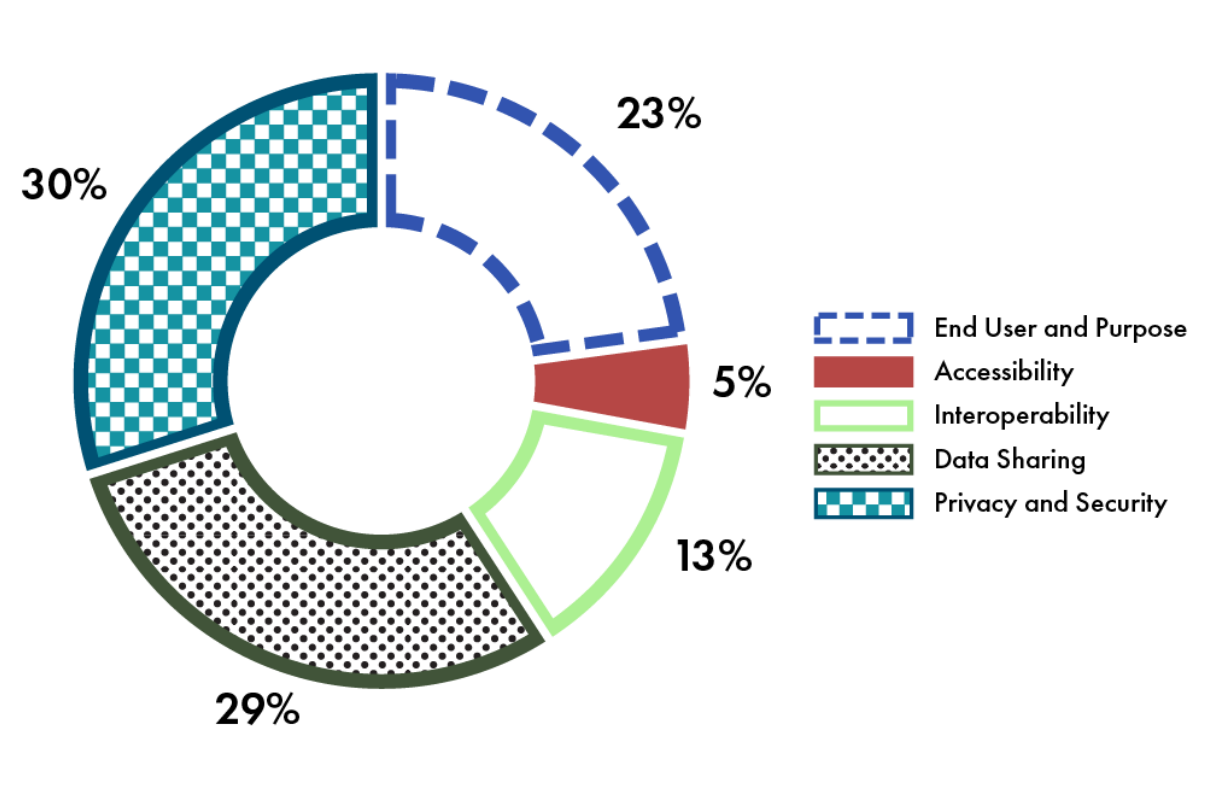
Figure 2. Frequency of gaps in the interviews and